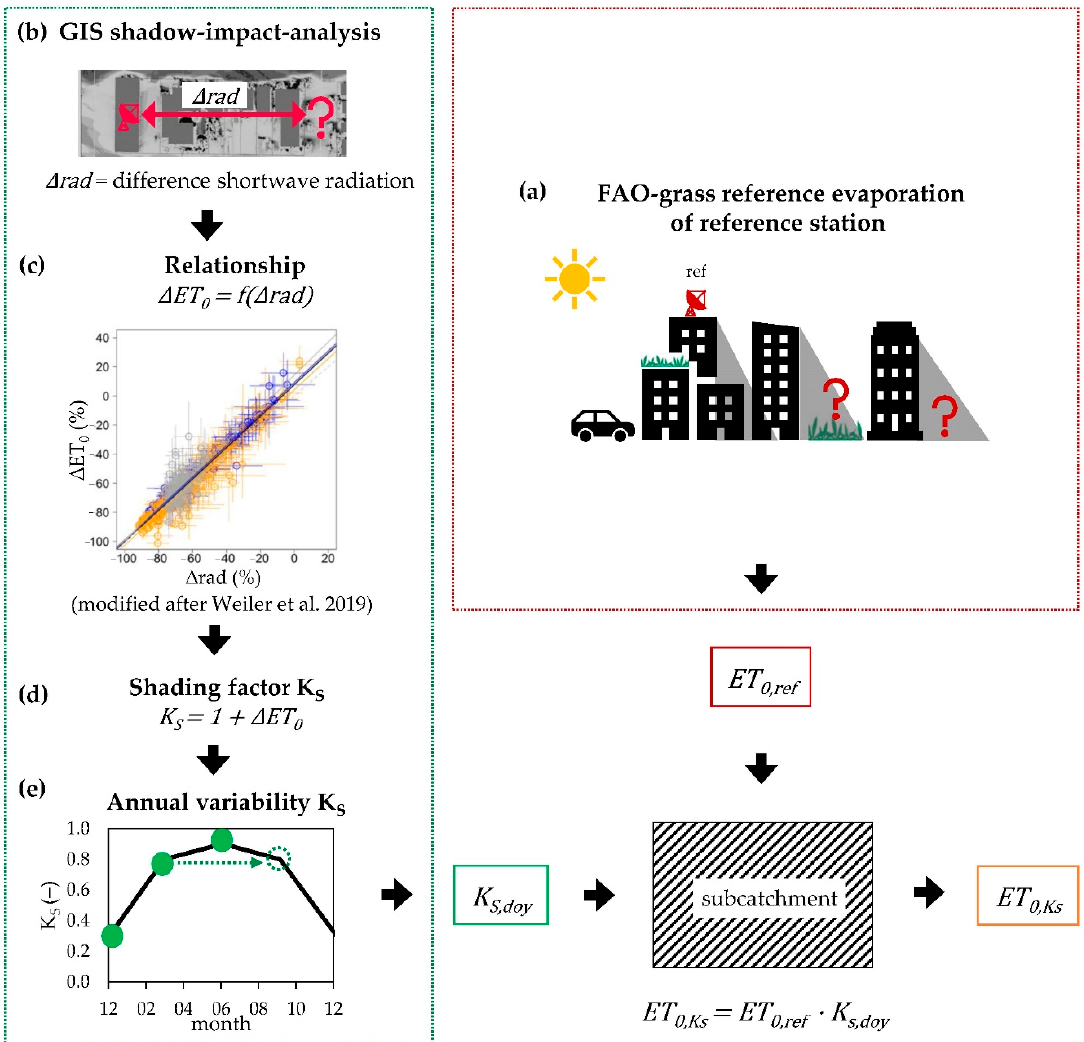
Figure 1. Schematic overview of Submodule 1.